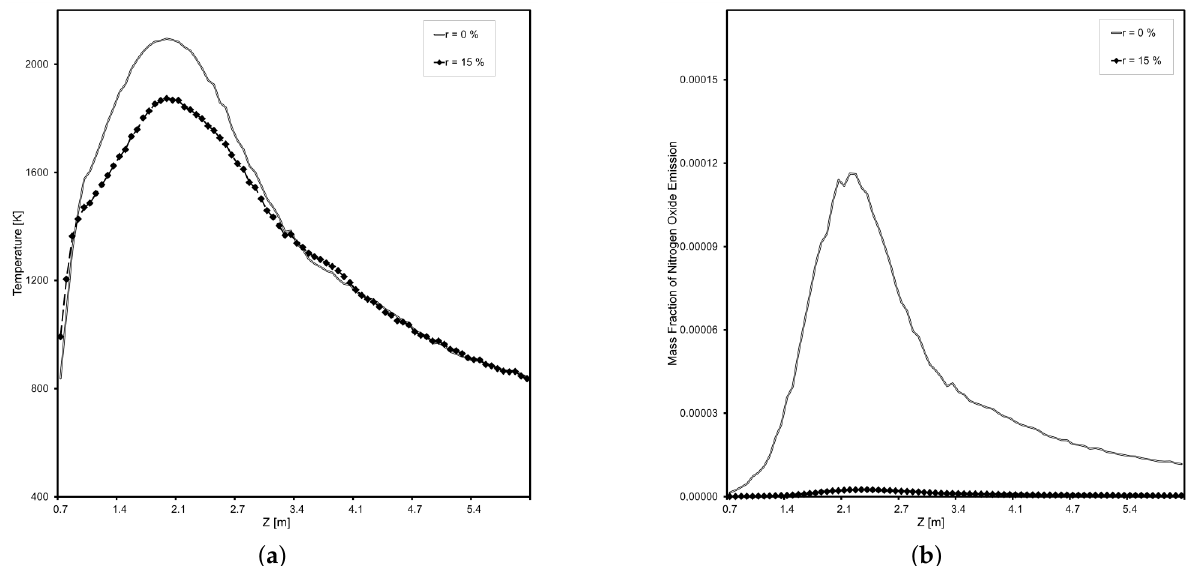
Figure 10. Study of the influence of the degree of recirculation during the combustion of a methane– air mixture of the type of power boiler E-500-13.8-560GMN (steam load of 315 tons per hour): ( a ) temperature comparison; ( b ) comparison of NO X